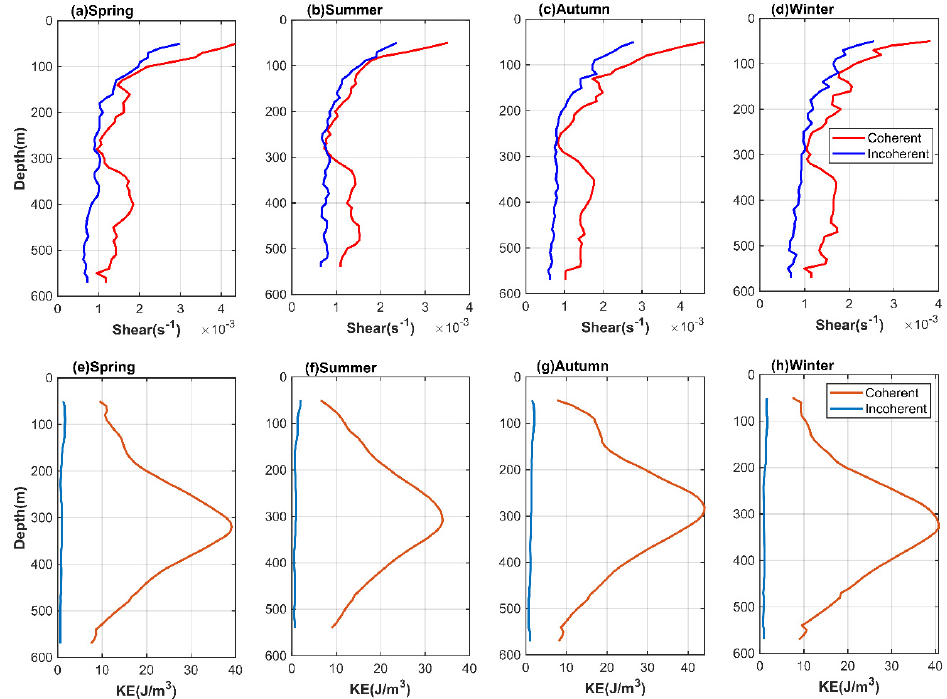
Figure 11. Vertical structures of the seasonal mean shear and kinetic energy densities of the coherent and incoherent components of D2 ITs. ( a – d ) indicate the shear in spring, summer, autumn, and winter, respectively, and ( e – h ) denote the kinetic energy densities in spring, summer, autumn, and winter, respectively.